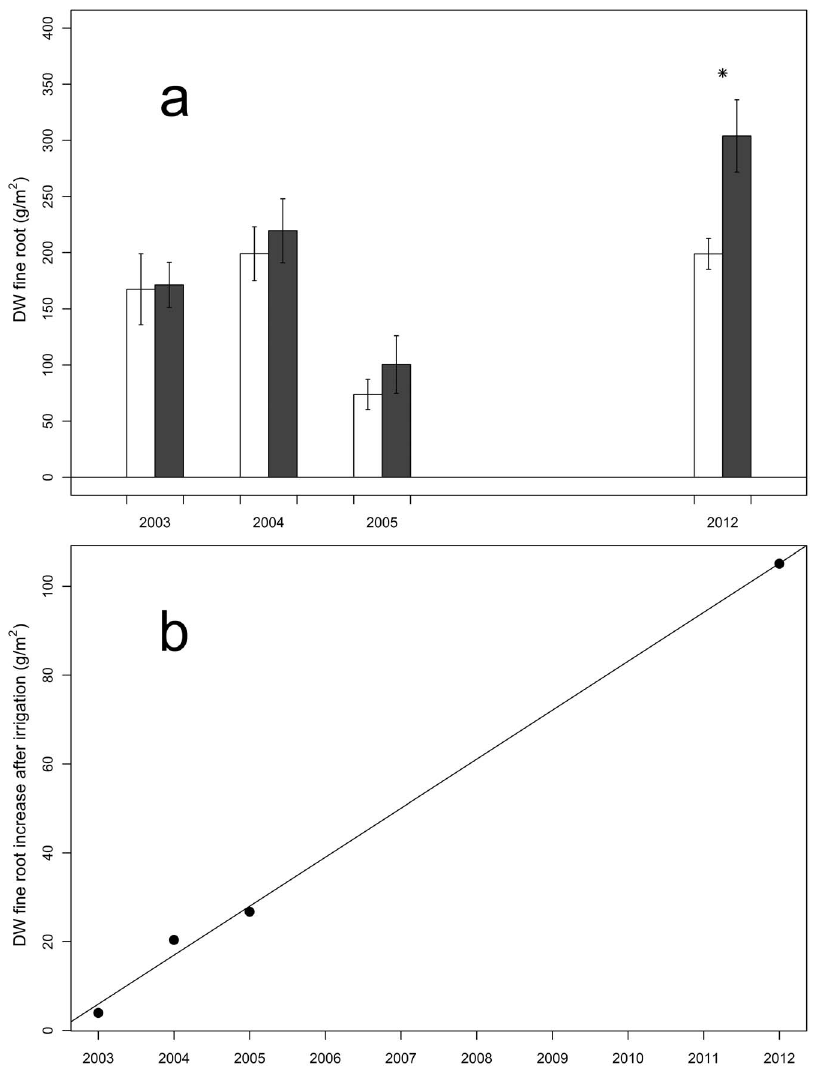
Figure 5. Fine root dry weight compared to data from Brunner et al. [23] (error bars = standard error), ( n = 4). (a) Fine root dry weight (g/ m 2 ) are shown as bar plots from 2003, 2004 and 2005 [23] compared to the 2012 detected. P -values , 0.05 calculated with a mixed model followed by ANOVA are marked with *. (b) A significant positive linear correlation of the Scots pine fine roots increased means could be shown (R2= 0.9958, p - values=